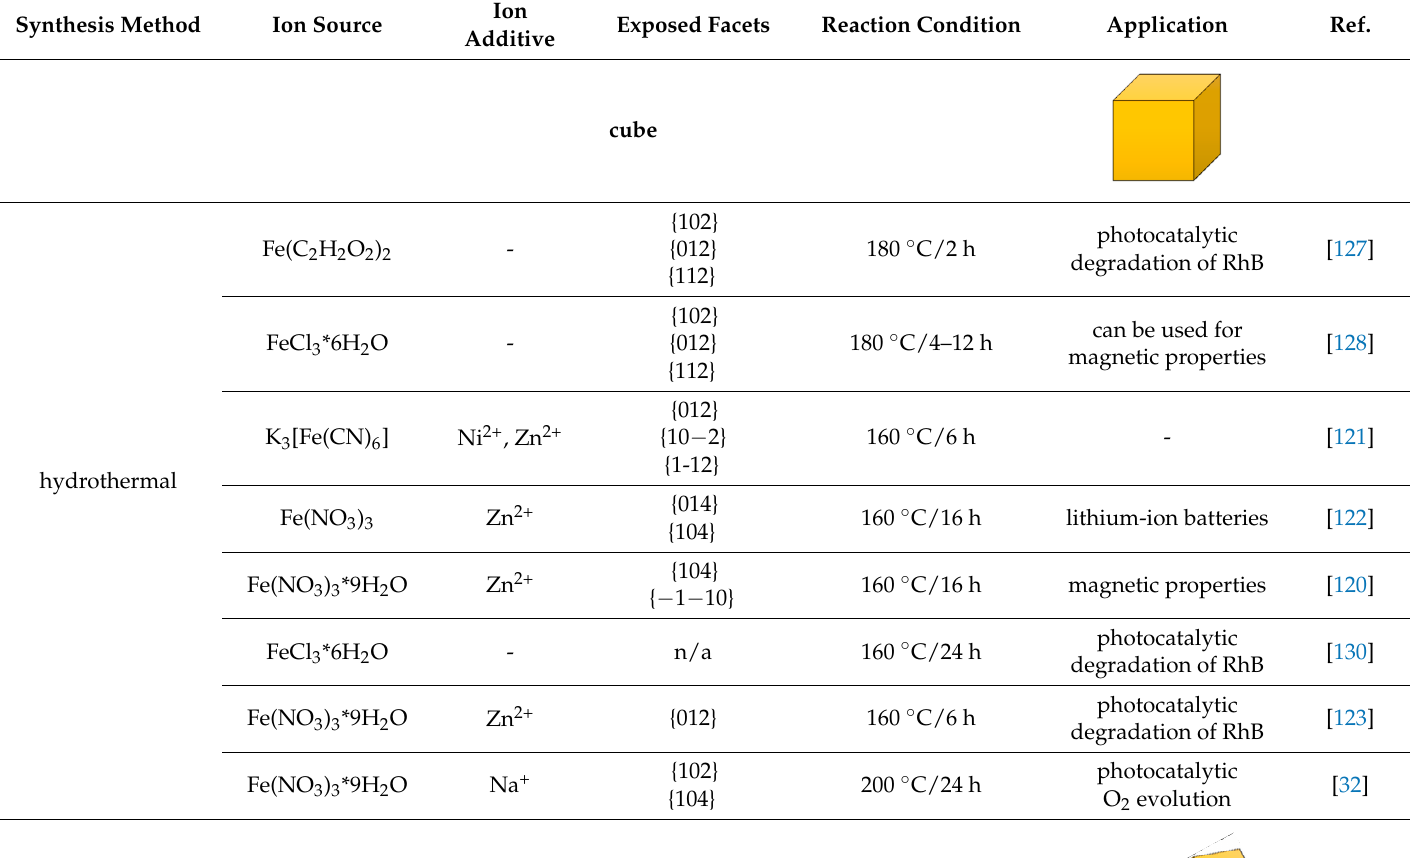
Table 4. Comparison of synthesis methods and application of various facet-dependent α -Fe 2 O 3.